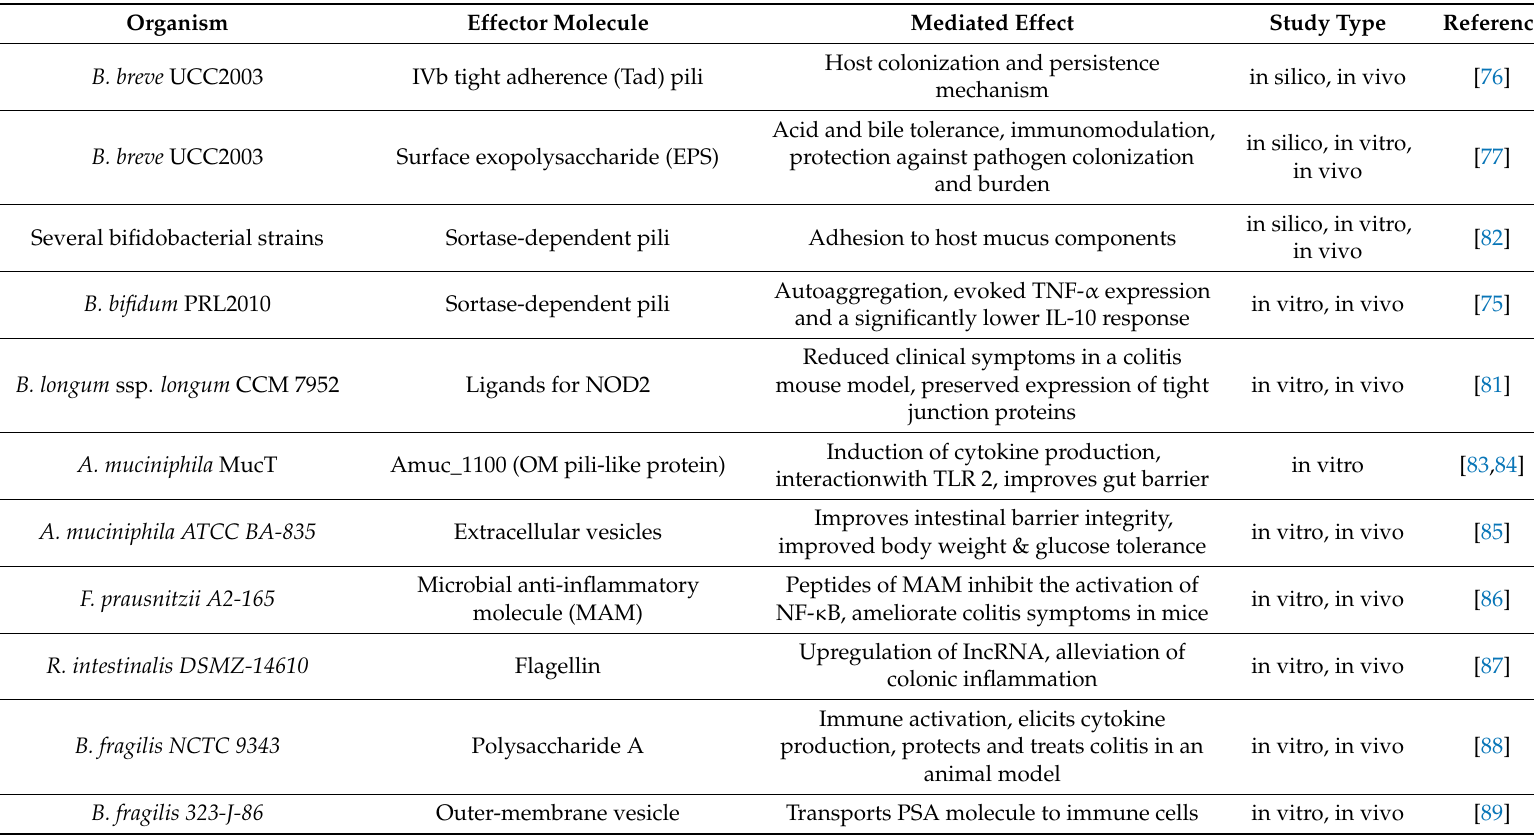
Table 1. Known effector molecules of the selected commensal bacteria and their effect on intestinal health. All in vivo studies were mice